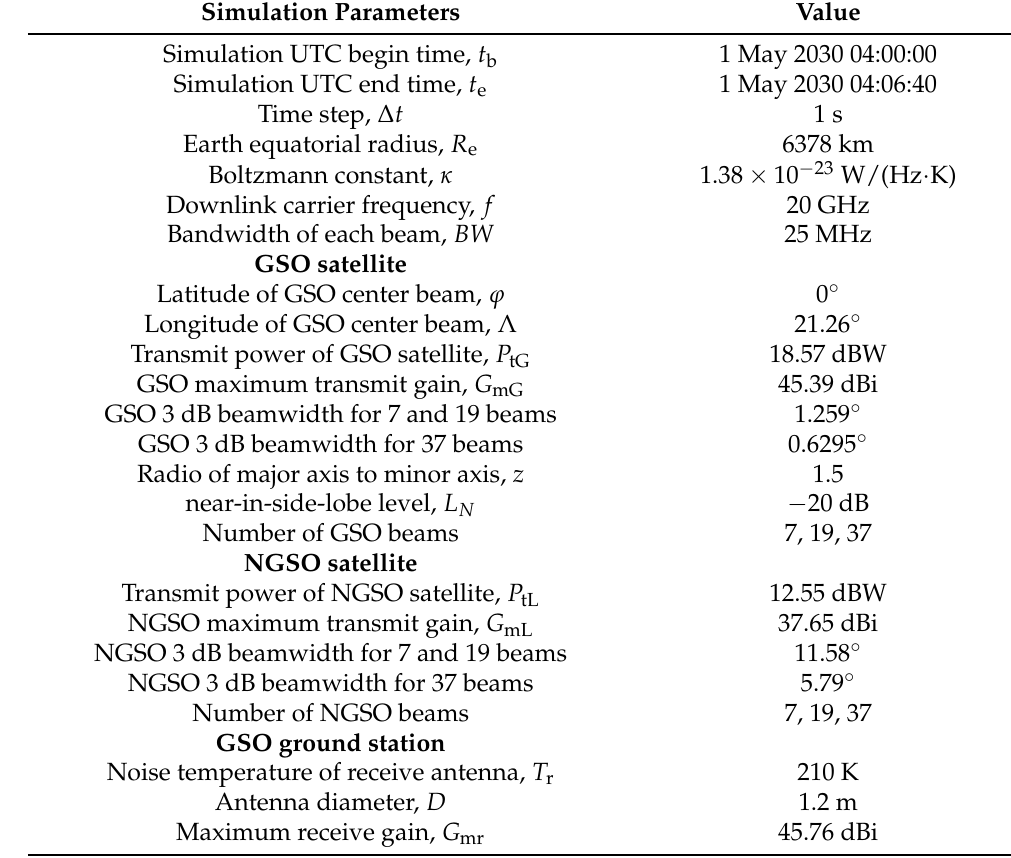
Figure 14. Change of total capacity with and without channel allocation and variation of rotation angle for the 37-beam scenario. ( a ) Change of total capacity with and without channel allocation for the 37-beam scenario; ( b ) Variation of rotation angle for the 37-beam scenario. Table 2. Simulation